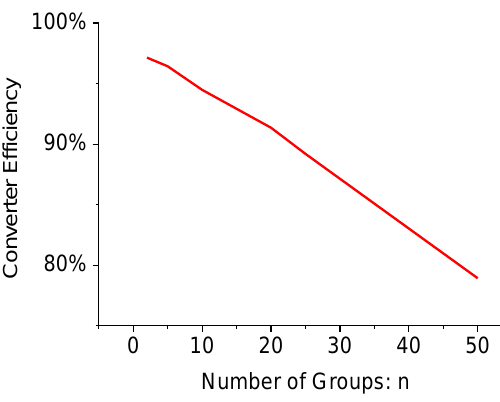
Figure 9. Relationship between η and the number of groups.